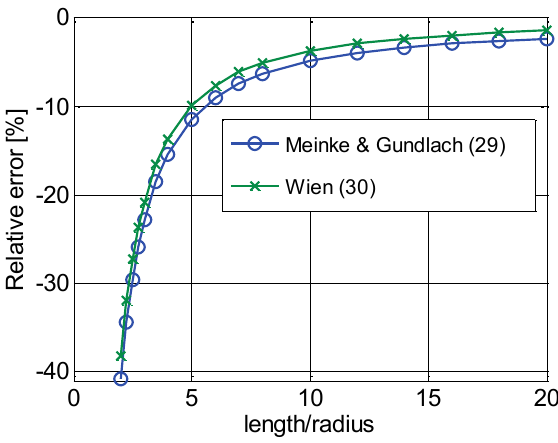
Figure 4: Relative errors of formulae (29) and (30) due to Meinke-Gundlach and Wien, respectively.